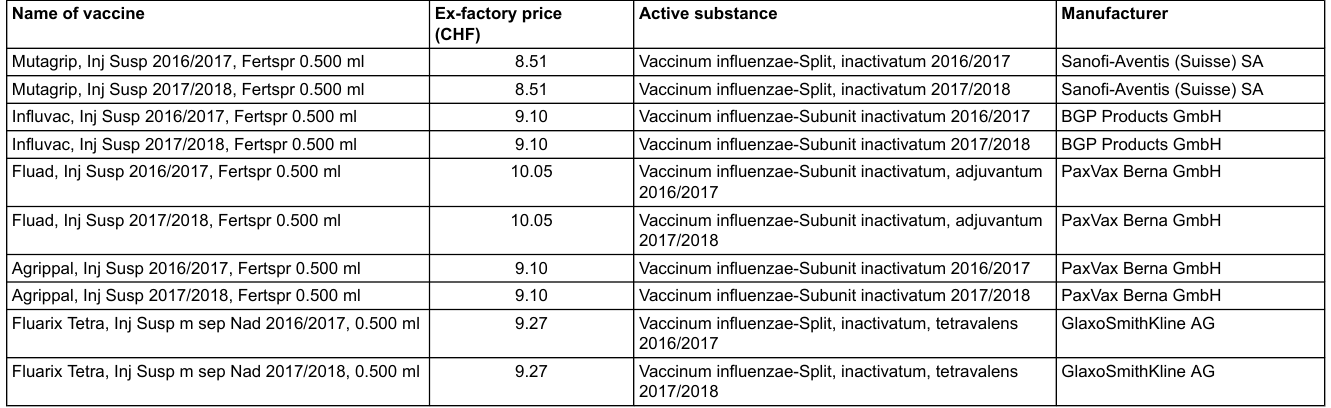
Table S1: List of influenza vaccines, retrieved from the Sasis datapool.